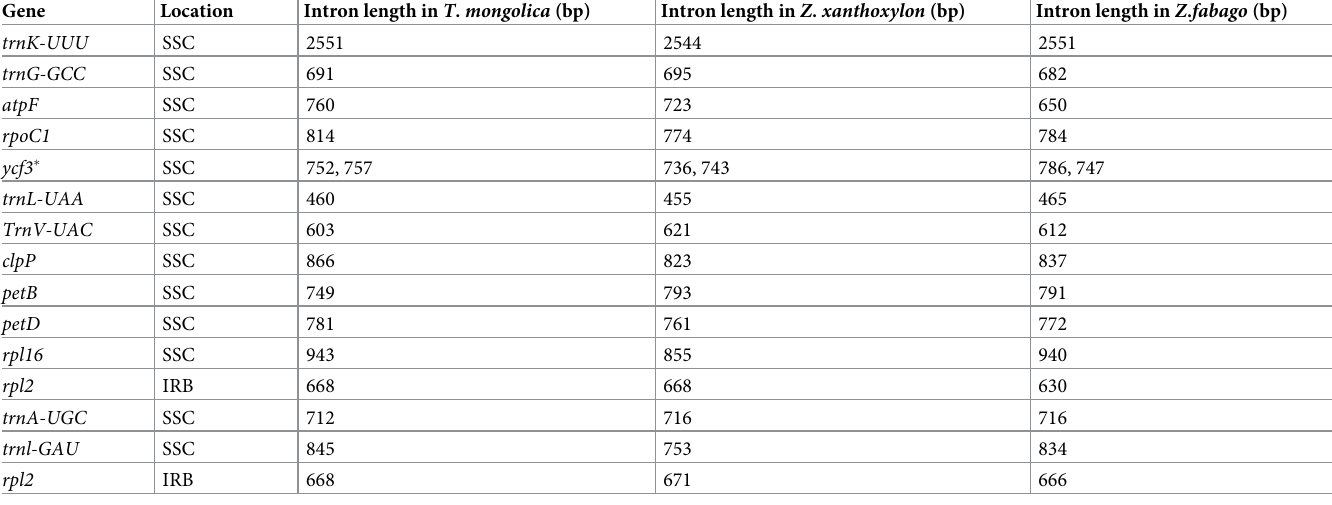
Table 3. Intron-containing genes in chloroplast genomes of T . mongolica , Z . xanthoxylon and Z . fabago . Gene